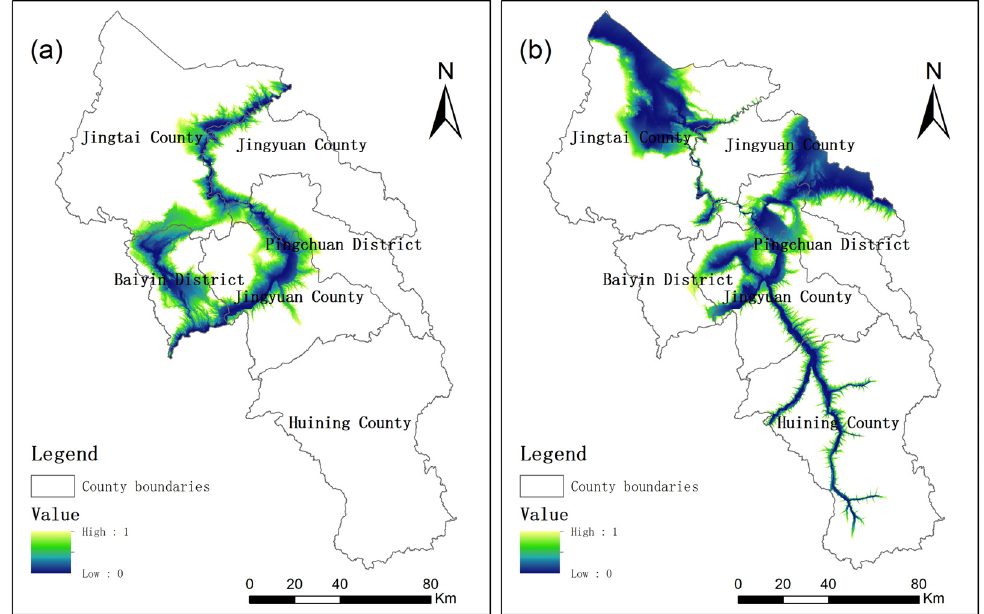
Figure 6. ( a ) CIUs of the Yellow River and the central city trunk canal; ( b ) CIUs of other